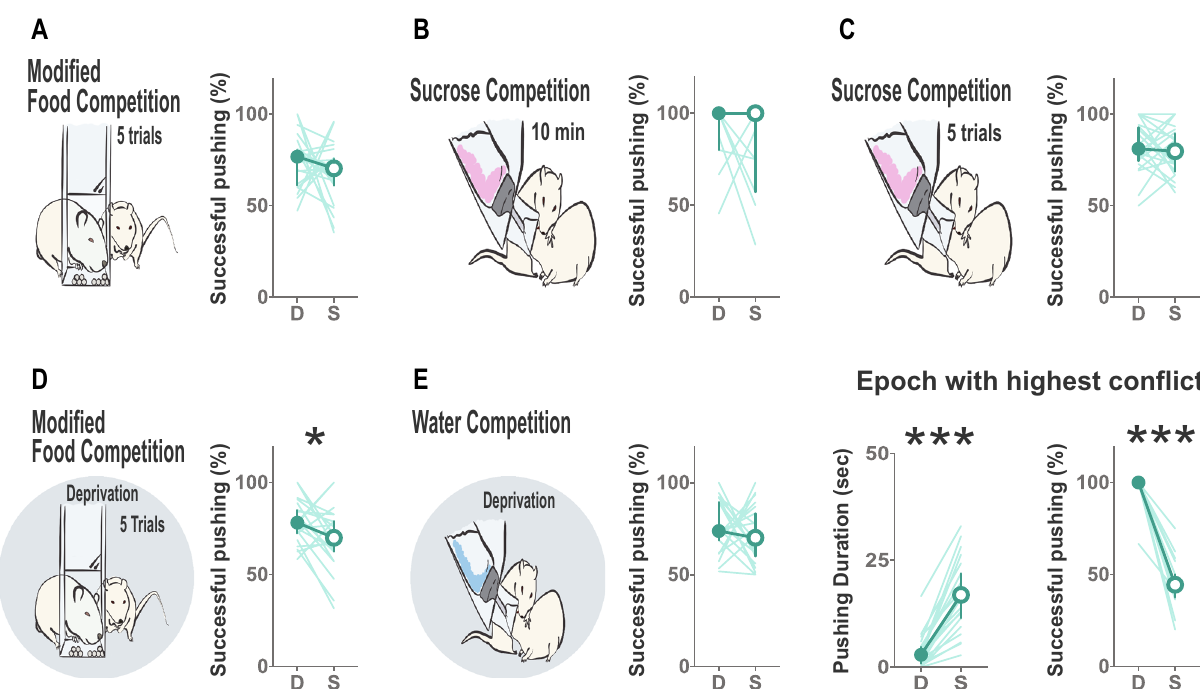
Figure 5. Dominant animals are more successful in displacing their subordinate partners to gain access to resources when in deprivation states. Dominant animals showed a higher percentage of successfully pushing away their subordinates while gaining access to the resources in moments with high conflict. Percentage of successful pushing did not reach significance in the modified Food Competition ( A ), Sucrose competition with continuous ( B ) or Intermittent access to the bottle ( C ) but was significantly different in the Food Competition under deprivation ( D ). No differences were observed in the efficiency of pushing behavior in the Water Competition task ( E ). However, when assessing these differences in the moments with highest conflict in this test, defined as the bout where intense drinking was displayed and high levels of pushing behavior were observed, submissive animals spent more time pushing, but dominant animals were almost always successful to displace their partners in every bout of pushing. D: dominant, S: submissive according to the consumption in each test. Median, 95% CI and individual values for all animals are represented. * p < 0.05, *** p <